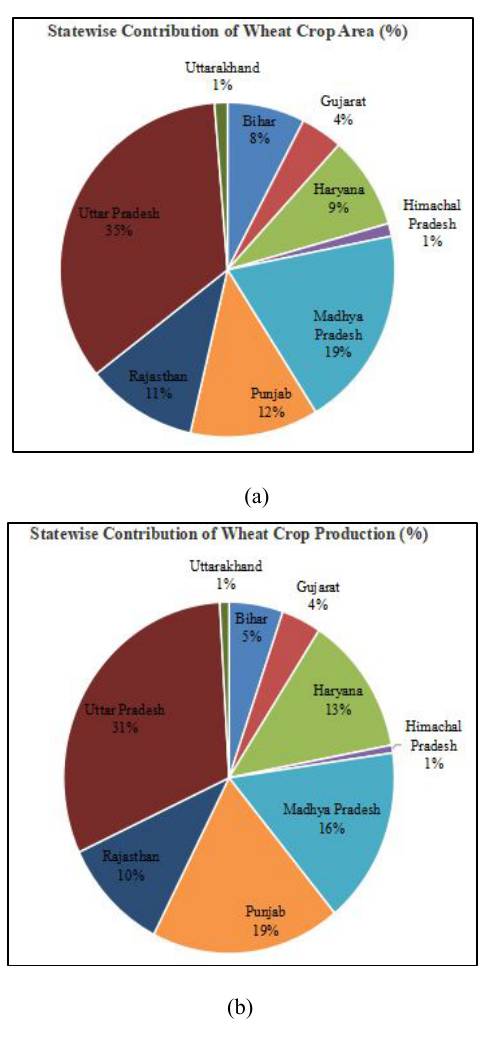
Figure 1. Major wheat growing states of India